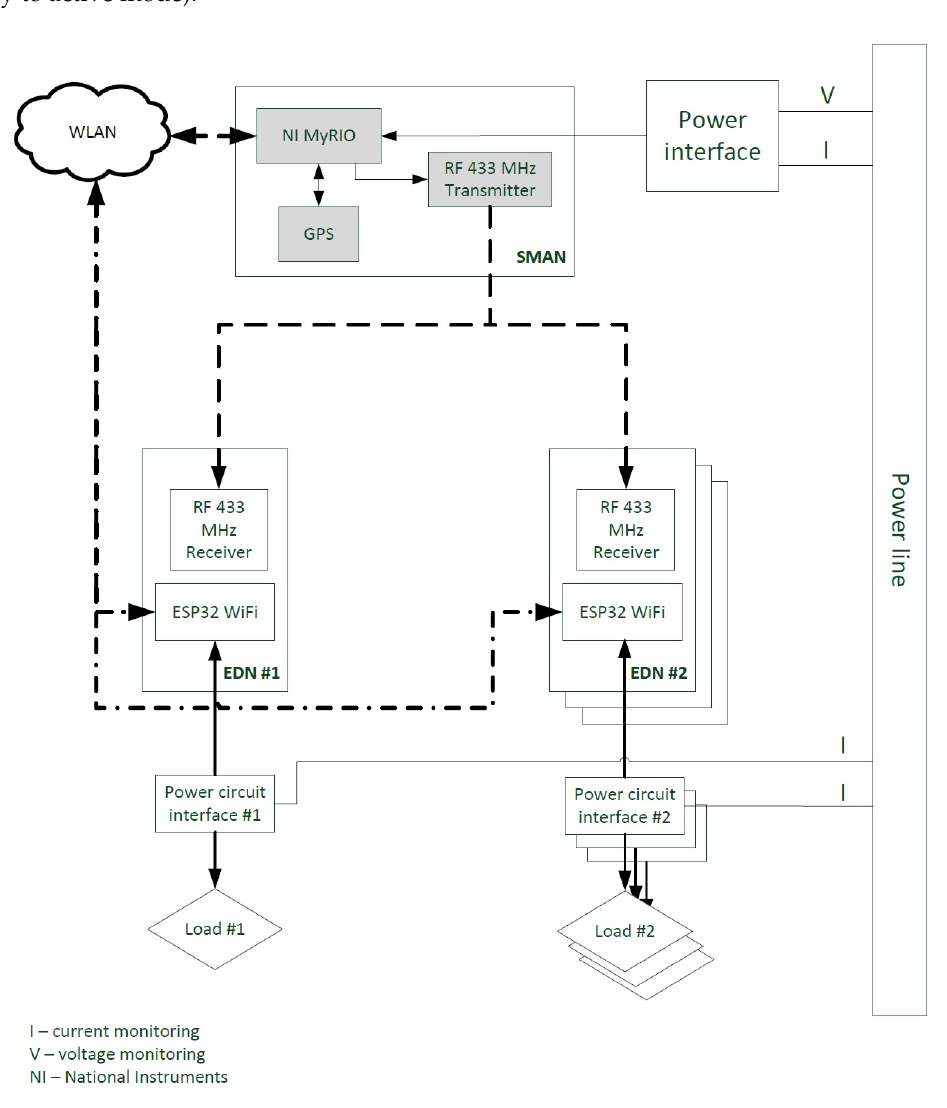
Figure 9. Block diagram of the Natural Subset Acquisition System